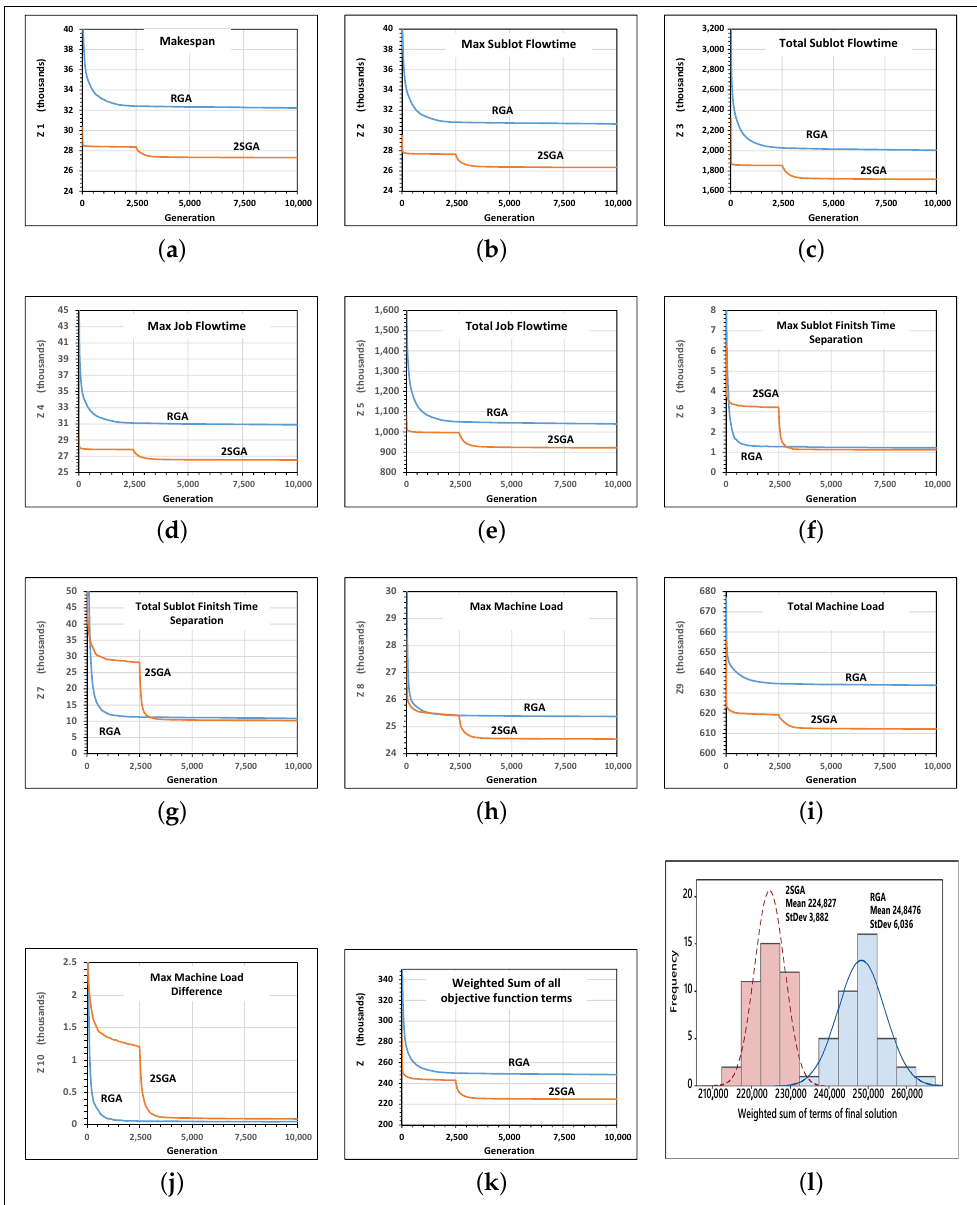
Figure 12. The convergence of 2SGA and RGA in solving Problem 4 while all the objective terms are optimized simultaneously. (Each convergence graph ( a – k ) is an average of 40 trials, and ( l ) is the histogram of the final values of objective function in these 40